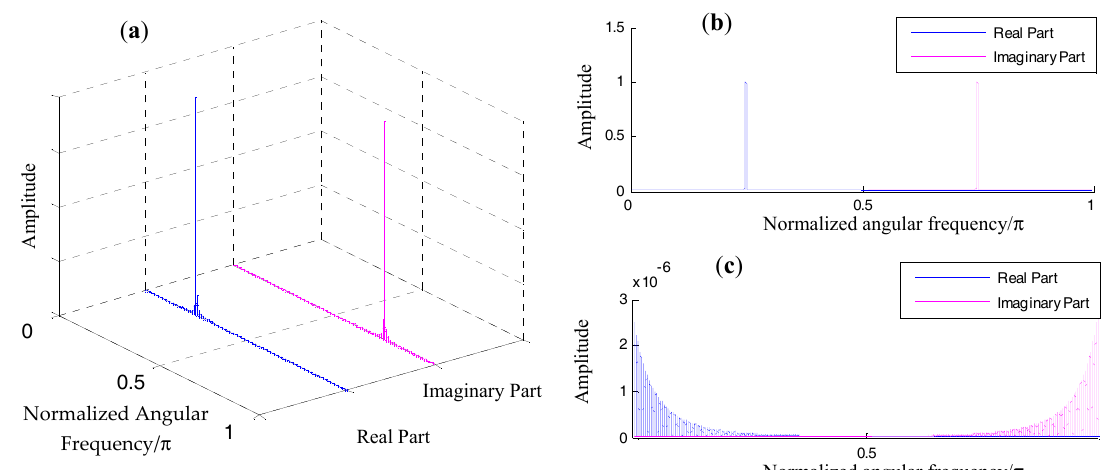
Figure 6. Demonstration of spectral aliasing of a Hanning window: ( a ) magnitude response of the positive component and the negative component in a 3D coordinate; ( b ) magnitude response of the positive component and the negative component in a 2D coordinate; ( c ) zoomed-in plot of ( b ). A Hanning window offers better energy concentration in comparison with a rectangular